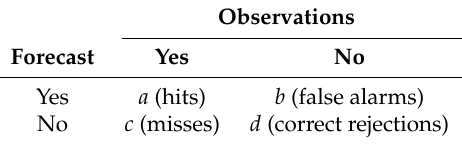
Table 3. Contingency